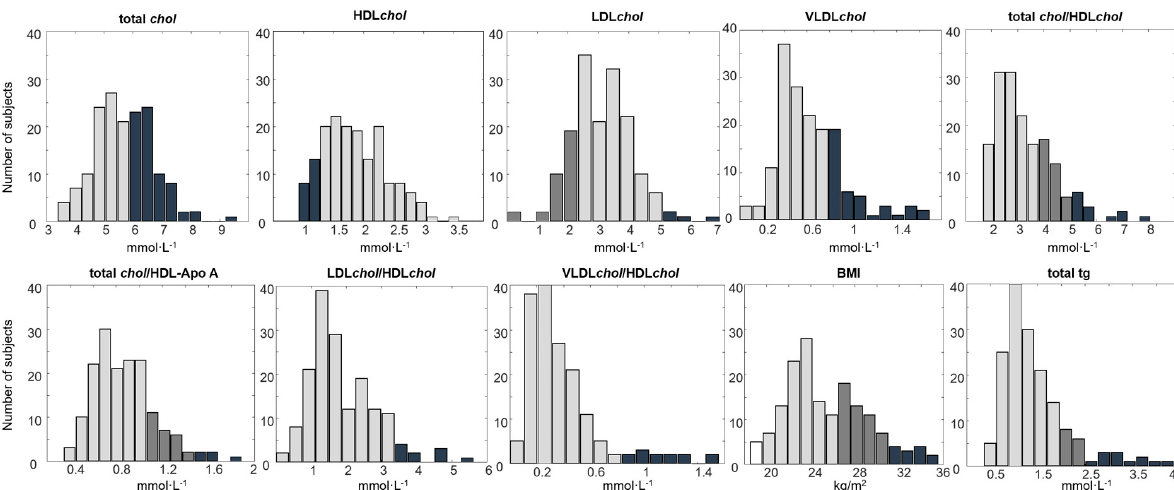
Figure 1. Histograms showing the distributions of human blood lipoproteins (LPs), their ratios, and BMI across the 163 subjects included in this study. The four colors in the figure represent four levels of risk thresholds set in the Danish healthcare system [21], including below the normal range (white), normal range (light grey), borderline range (dark grey), and under risk (black). The unit for LP levels and total tg is mmol/L, and that for BMI is kg/m 2 . BMI = body mass index, HDL chol = high-density lipoprotein cholesterol, VLDL chol = very-low-density lipoprotein cholesterol, LDL chol = low-density lipoprotein cholesterol, total tg= total triglycerides, total chol = total cholesterol and total chol /HDL chol , HDL-Apo A = high-density lipoprotein-Apolipoprotein A.